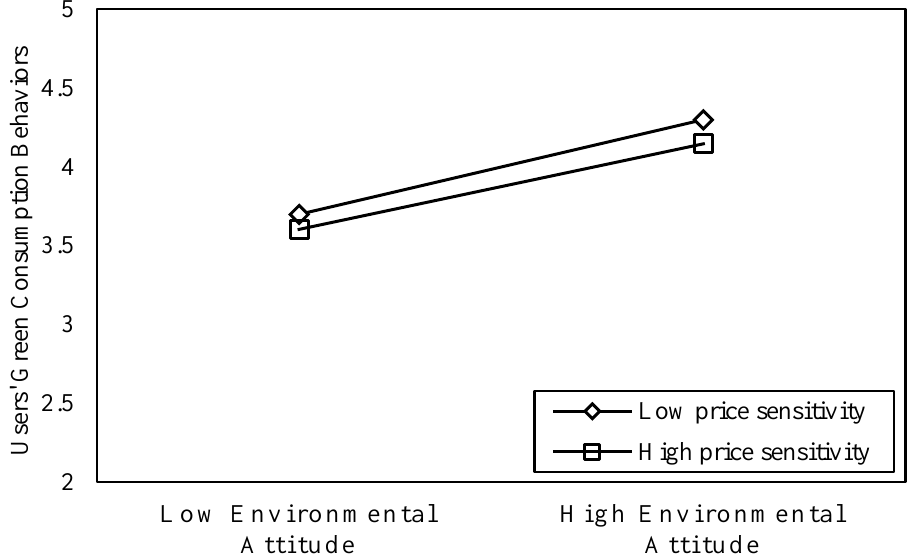
Figure 2. The moderating effect of price sensitivity on the relationship between environmental attitude and green consumption behavior.